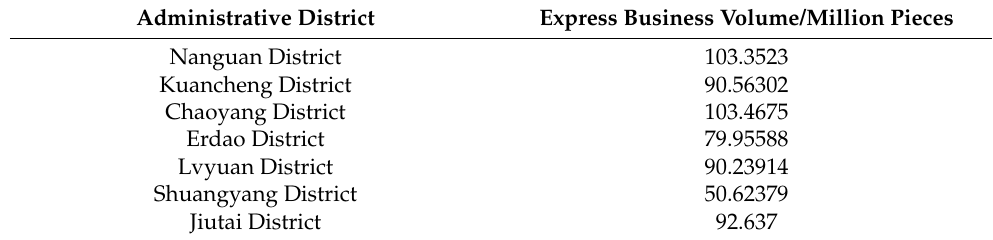
Table 7. Express business volume by district.